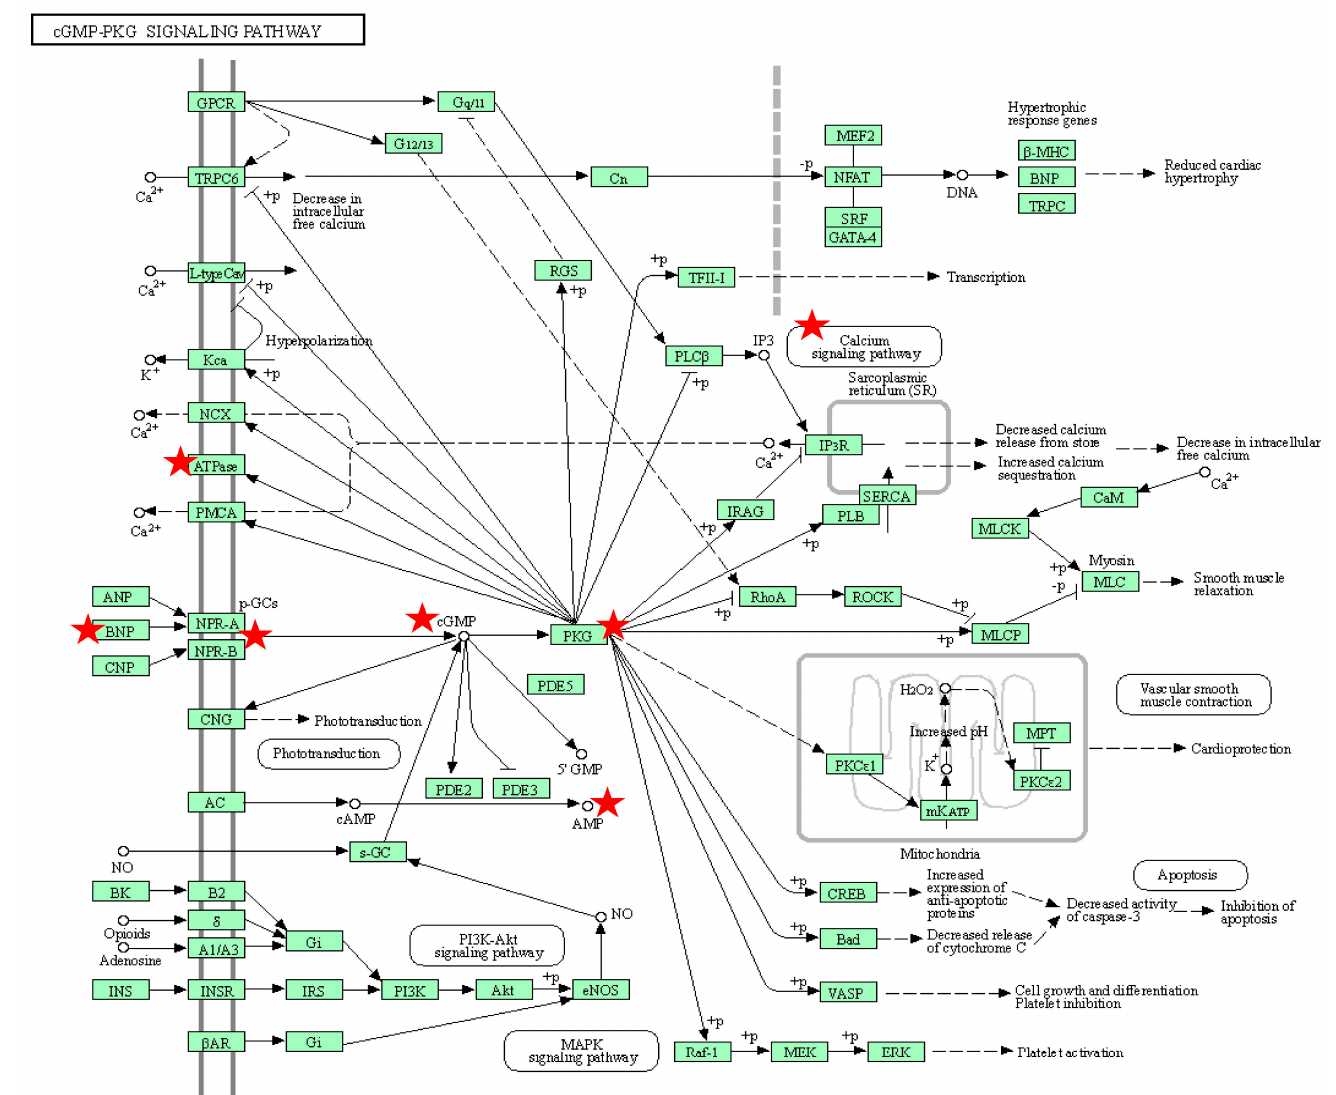
Figure 4. The cGMP-PKG signaling pathway. The activity of CGMP-PKC is activated through the binding of the CNP ligand (2’,3’-cyclic-nucleotide 3’-phospodiesterase) with the NPR-B receptor (guanylate cyclase). The response of the activation mechanism causes the conversion of adenosine triphosphate (ATP) into cAMP, which is important for the movement of spermatozoa.